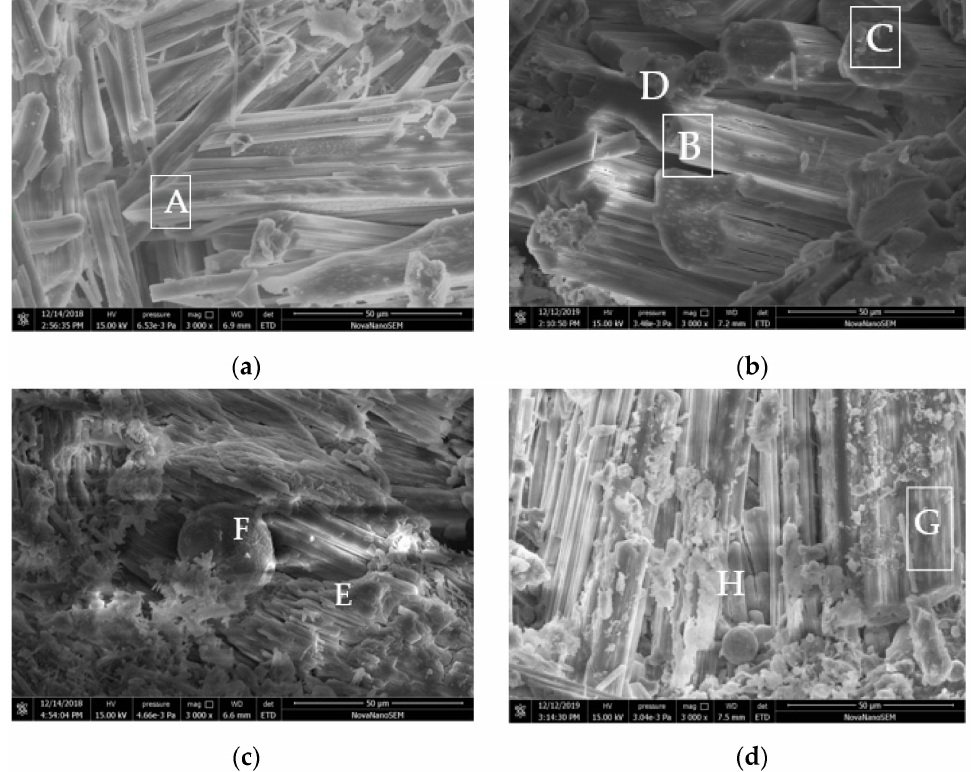
Figure 6. SEM images of MKPC samples. ( a ) M0 natural curing 28 d; ( b ) M0 soaked in water for 36 d; ( c ) M1 natural curing 28 d; ( d ) M1 soaked in water for 360 d. Table 3. Main elemental contents in regions A–G according to EDS